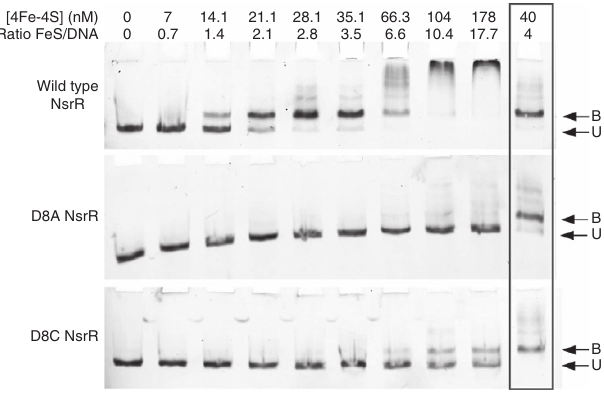
Figure 4 | EMSA analysis of DNA binding by ScNsrR variants. Compared are the binding affinities of the wild type protein and its D8A and D8C variants to the ScNsrR-specific DNA promoter hmpA1 site. The D8A variant displayed no affinity to this site while the D8C variant has lowered affinity. Box: reference sample of wild type ScNsrR. The [4Fe–4S] protein concentration was determined by UV-visible spectrometry. See also Supplementary Fig. 8. B, bound; U,